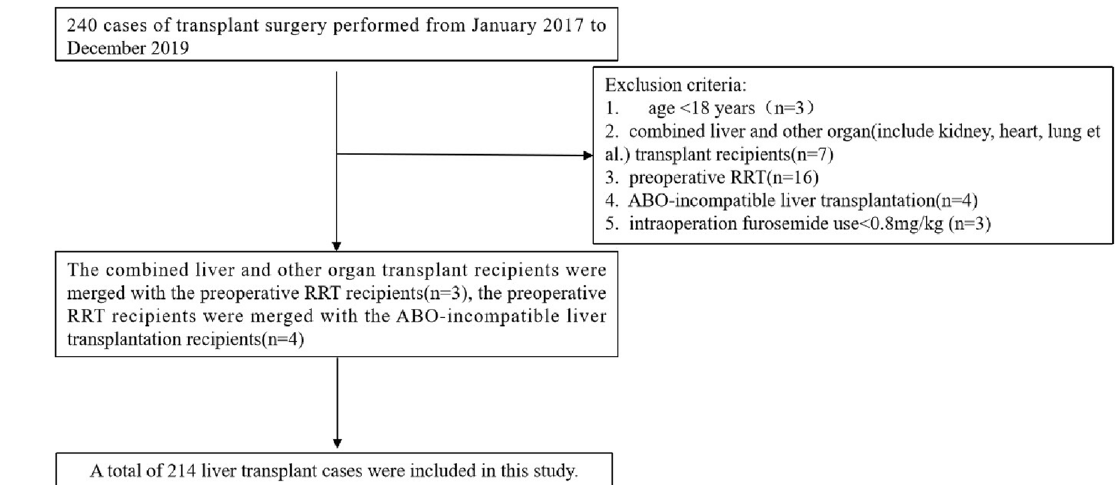
Figure 1. Patients